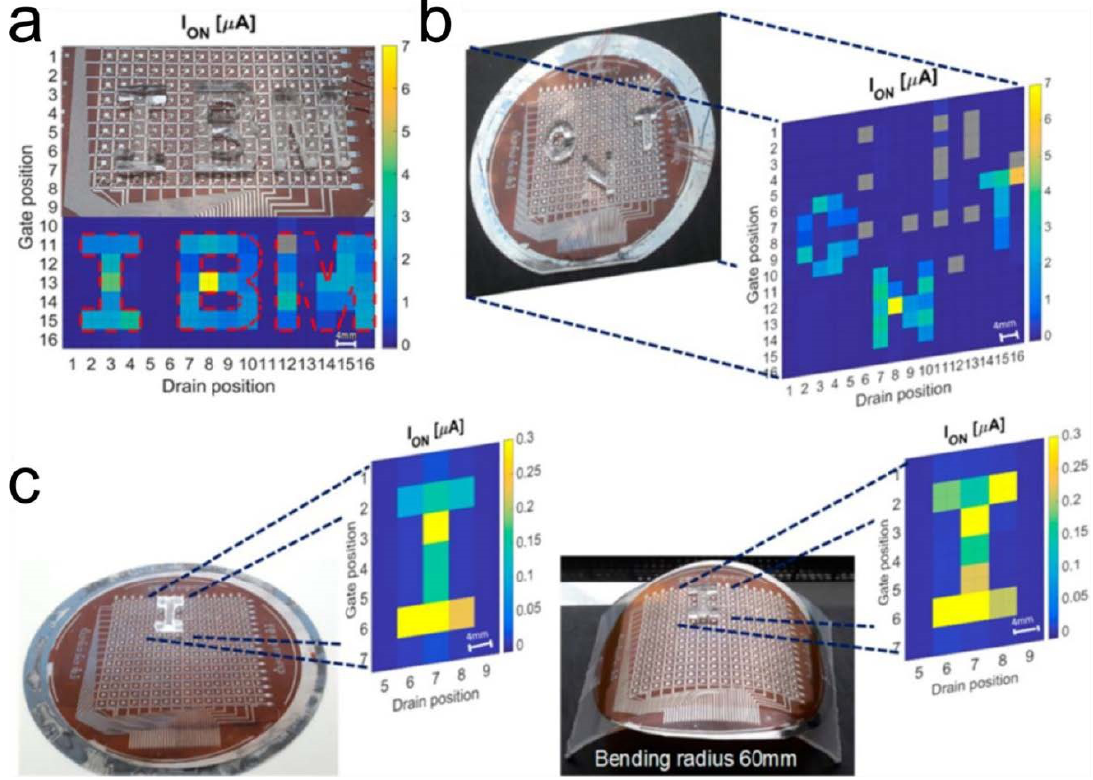
Figure 7. Pressure mapping of complex objects on flat and curved surfaces. ( a ) Current mapping of the CNT thin-film transistors active matrix showing the pressure sensing of “IBM” logo made by polydimethylsiloxane (PDMS) polymer. ( b ) Current mapping for the pressure sensing of word “CNT” made by PDMS. The defective pixels are labeled in gray color. ( c ) Comparison of pressure sensing on flat (left) and curved (right) surfaces with a bending radius of 60 mm. In both mappings, the pressure applied is 6.8 kPa. Reprinted from Ref. [90]. Copyright (2018) American Chemical Society.